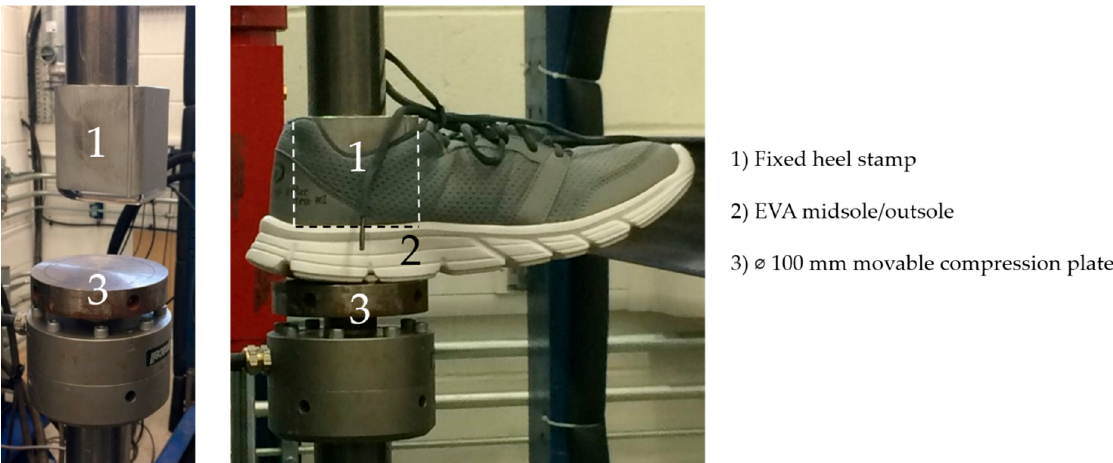
Figure 1. Mechanical ageing test setup. Heel stamp dimensions: rectangular section, w = 65 × 40 mm; semi-circular section radius = 32.5 mm; fillets = 10 mm on edges at sides and semi-circular rear